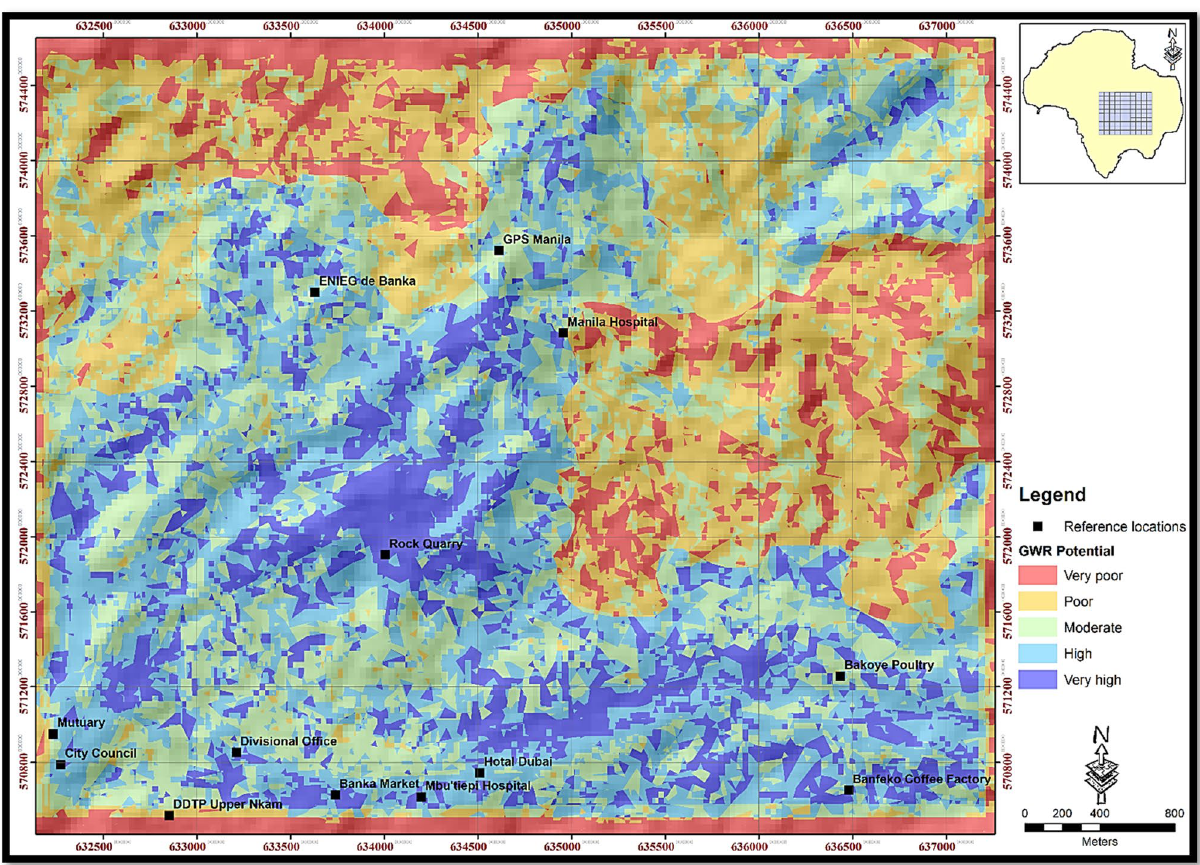
Fig. 12 Groundwater recharge potential map of study